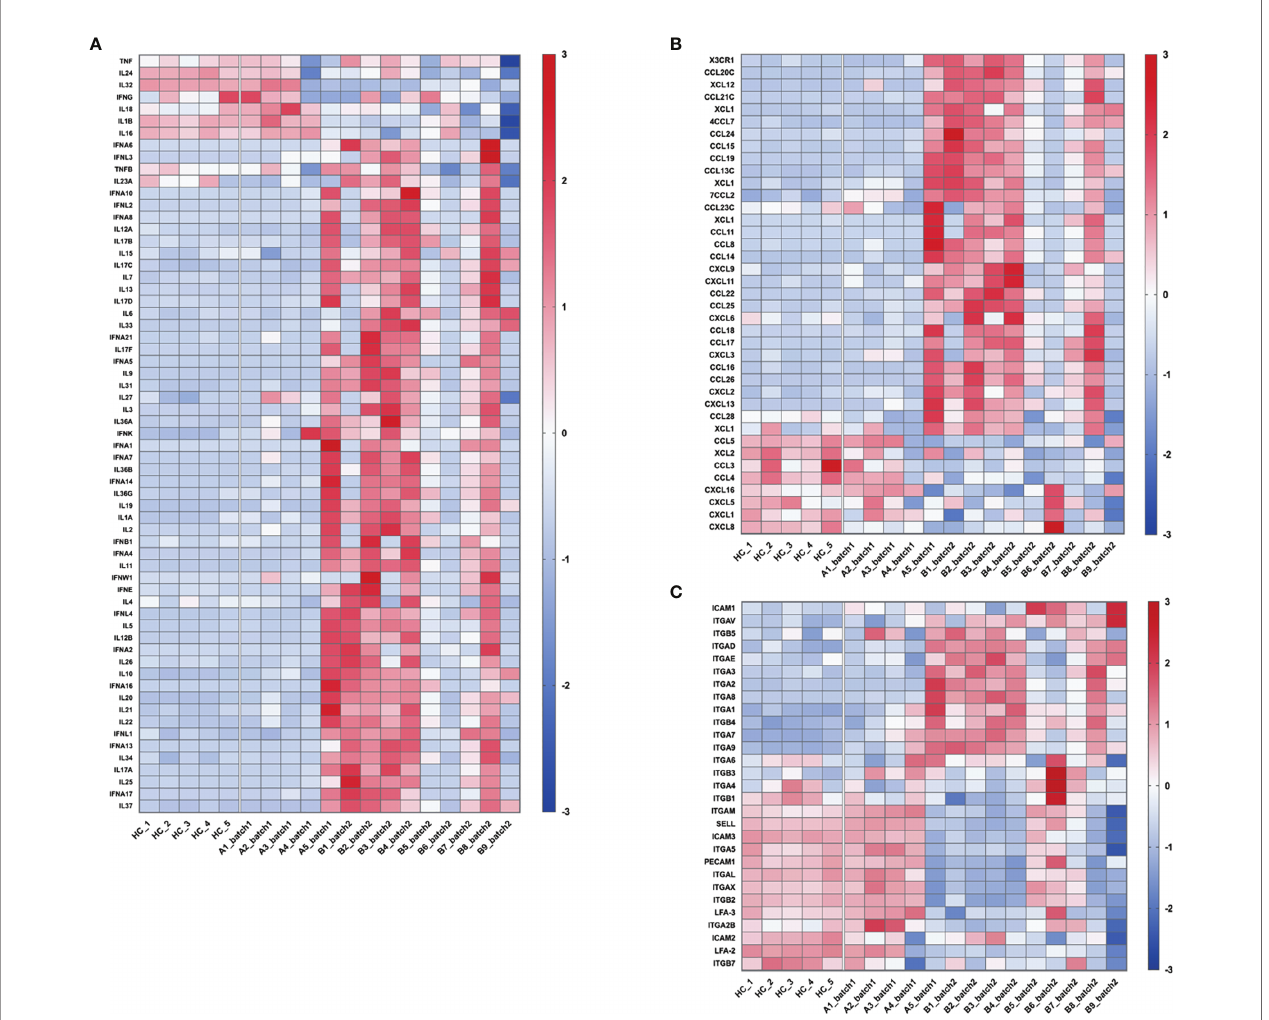
FIGURE 3 | Changes in the expression of genes related to “ cytokine storm ” and in fl ammation-related responses. These heatmaps show the relative expression levels of in fl ammation-related genes: (A) cytokines, (B) chemokines, and (C) adhesive molecules. In the heatmap, each row depicts a different gene, and each column depicts an individual subject, including healthy volunteers and enrolled patients. The relative expression levels of genes were calculated as log 10 FPKM, standardized with the z-score method, and then presented with a pseudocolor scale from -3 to 3. Blue represents downregulation, and red represents